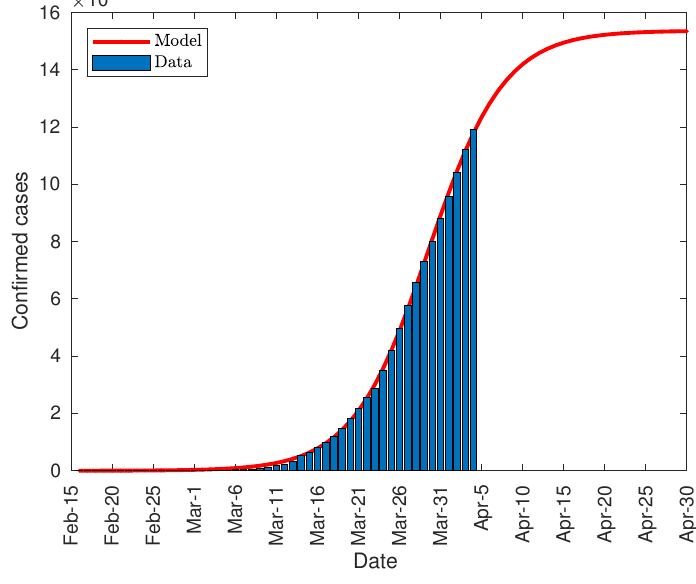
Figure 12. Total number of COVID-19 infections in Spain.